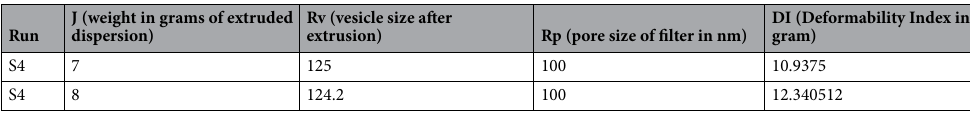
Table 5. Deformability indices of S4